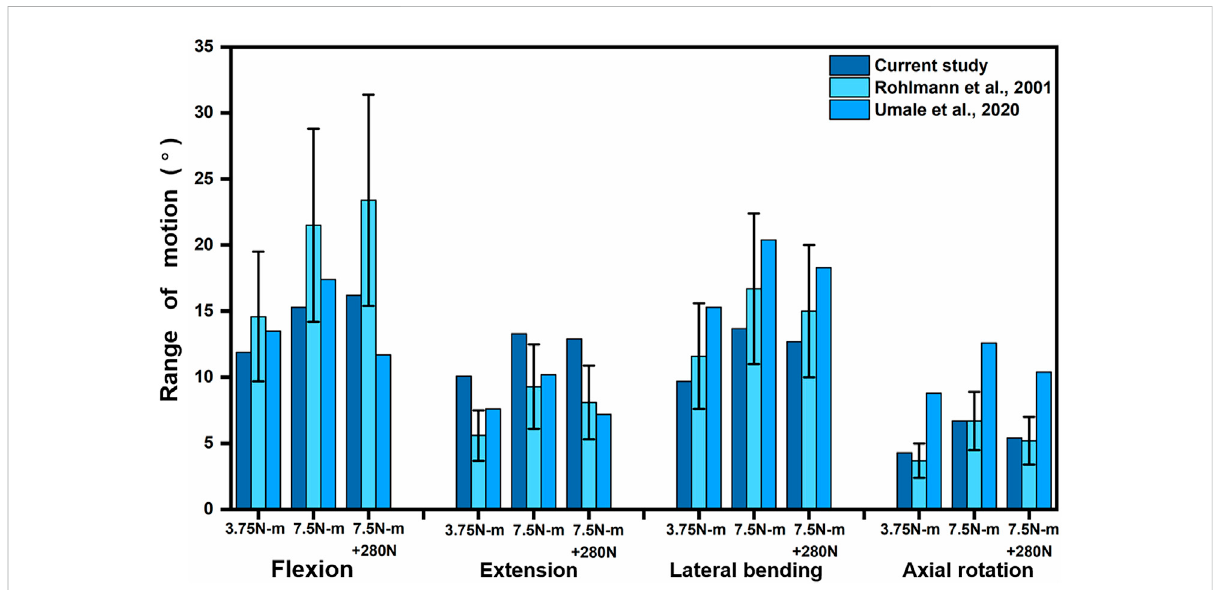
FIGURE 5 Comparison of L1-L5 total ROM between the present model and the results of previous publications under pure moments of 3.75N-m and 7.5N-m as well as 7.5N-m moments combined with 280N preload conditions at Flexion, extension, lateral bending, and axial rotation. Error bars represent standard deviation.